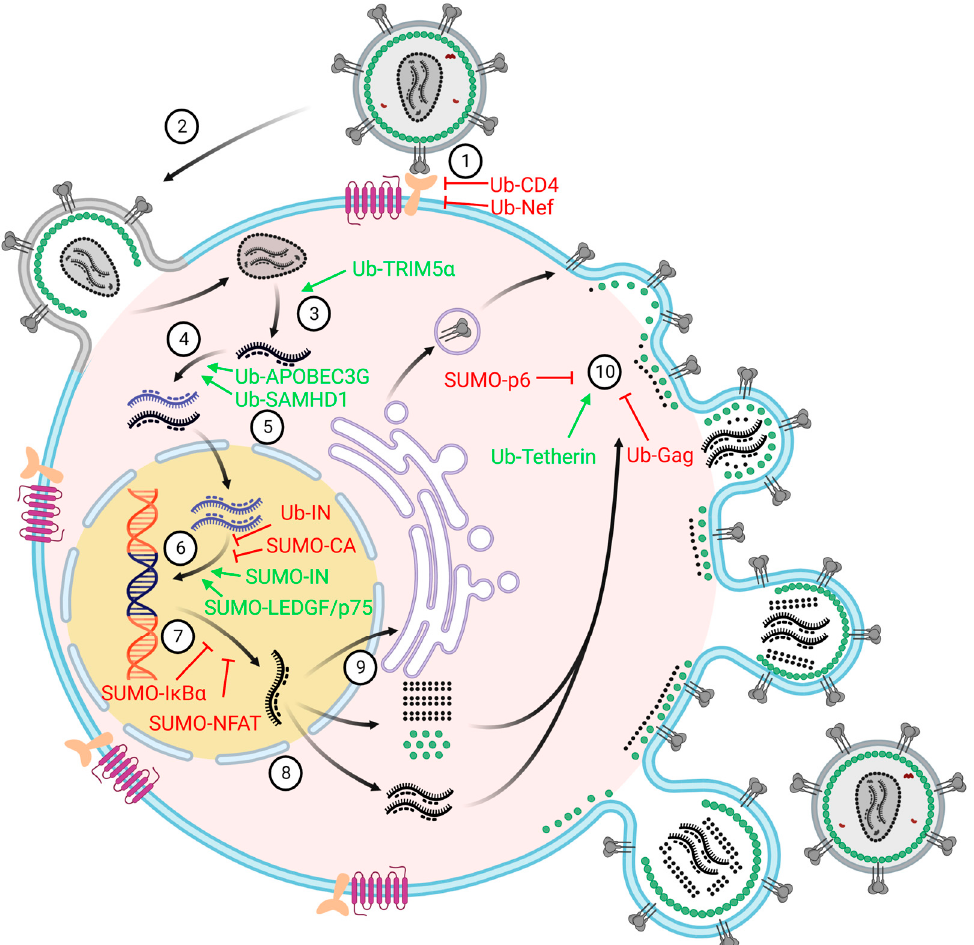
Figure 3. Schematic of the HIV-1 life cycle and corresponding restriction or activation factors. The numbered positions represent 10 steps of the HIV-1 life cycle, which include receptor binding, membrane fusion, viral uncoating, reverse transcription, nucleus importing, provirus integration, RNA transcription, RNA exporting, protein translation, and the virions formation. Each step is regulated by both ubiquitinated (Ub) proteins and SUMOylated (SUMO) proteins, which are shown beside the number. Proteins and arrows marked “red” represent inhibiting HIV-1 infection. Proteins and arrows marked “green” represent promoting HIV-1 infection. The exact functions of each protein can be found within the main text and Table 1.